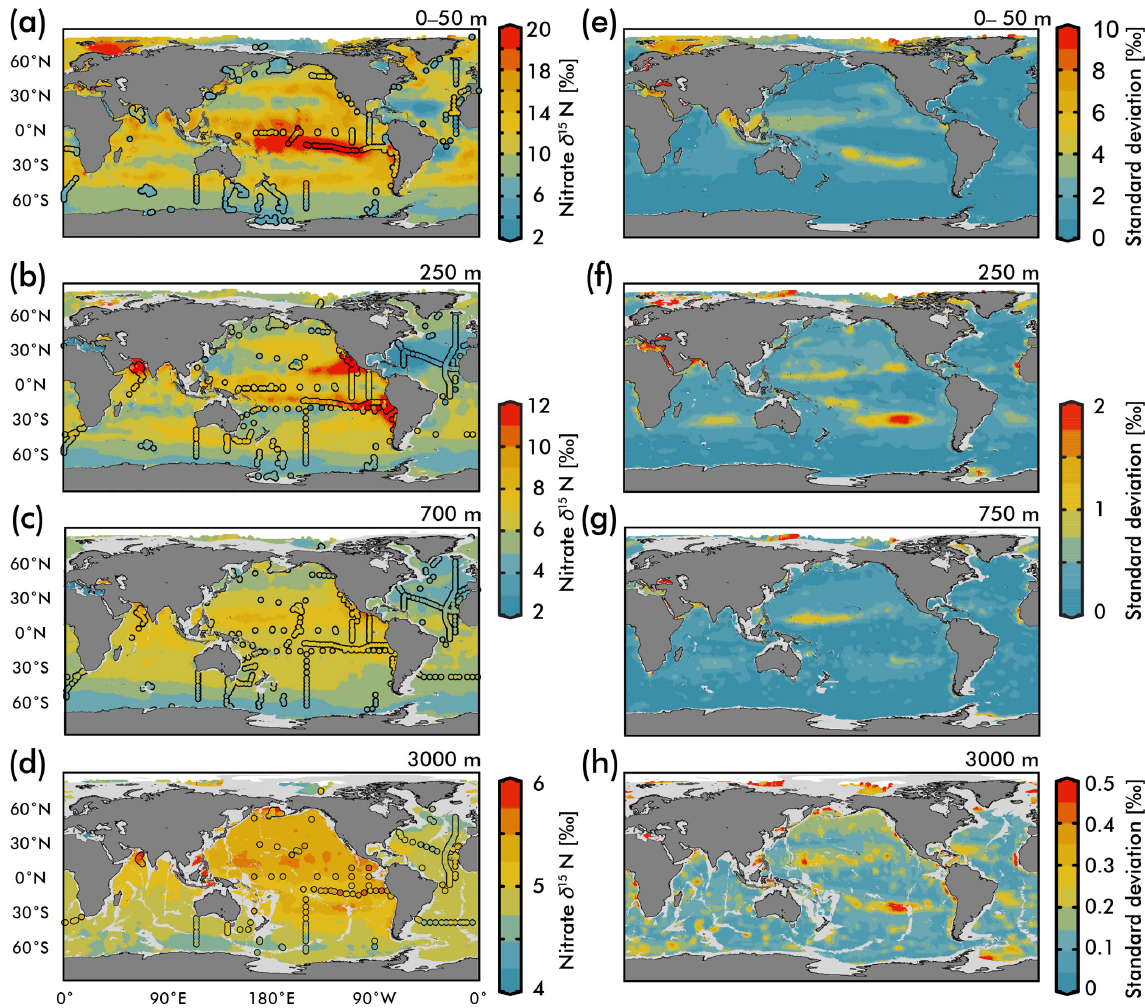
Figure 5. (Left) Map view of nitrate δ 15 N from our EANN and our observations (circles) for the (a) average over the 0–50m depth as well as the (b) 250m, (c) 700m, and (d) 3000m depth surfaces. (Right) Map views of nitrate δ 15 N error from the EANN model nitrate δ 15 N for the same depth surfaces on the